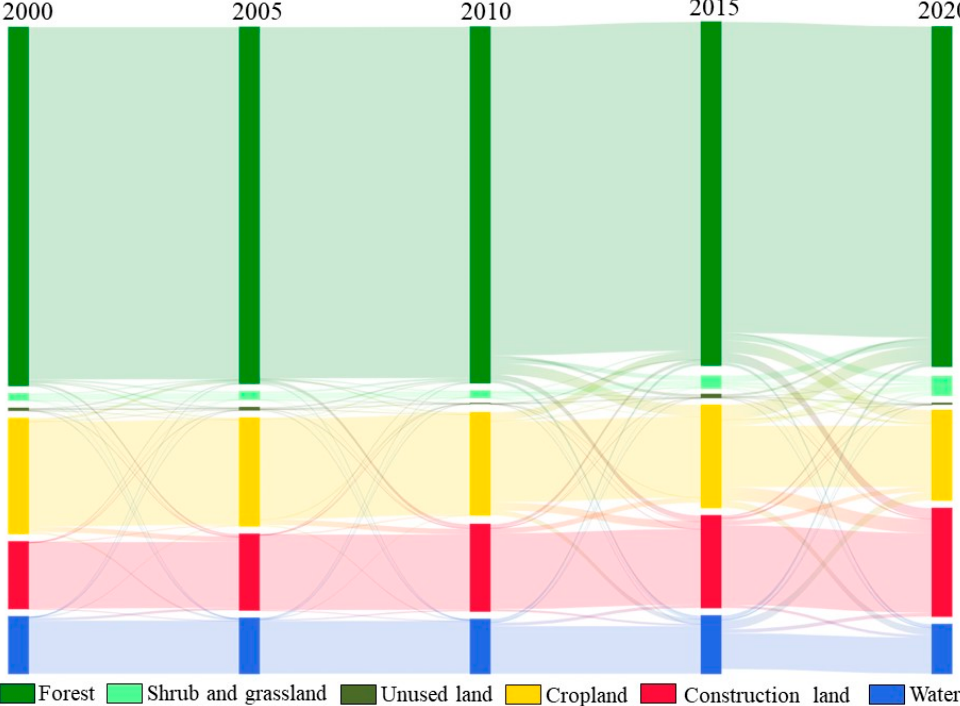
Figure 7. Sankey diagram for conversion between different land cover types in the GBA from 2000 to 2020. Note that different color lines represent the direction of land type transfer, and the width of the line represents the area transferred.